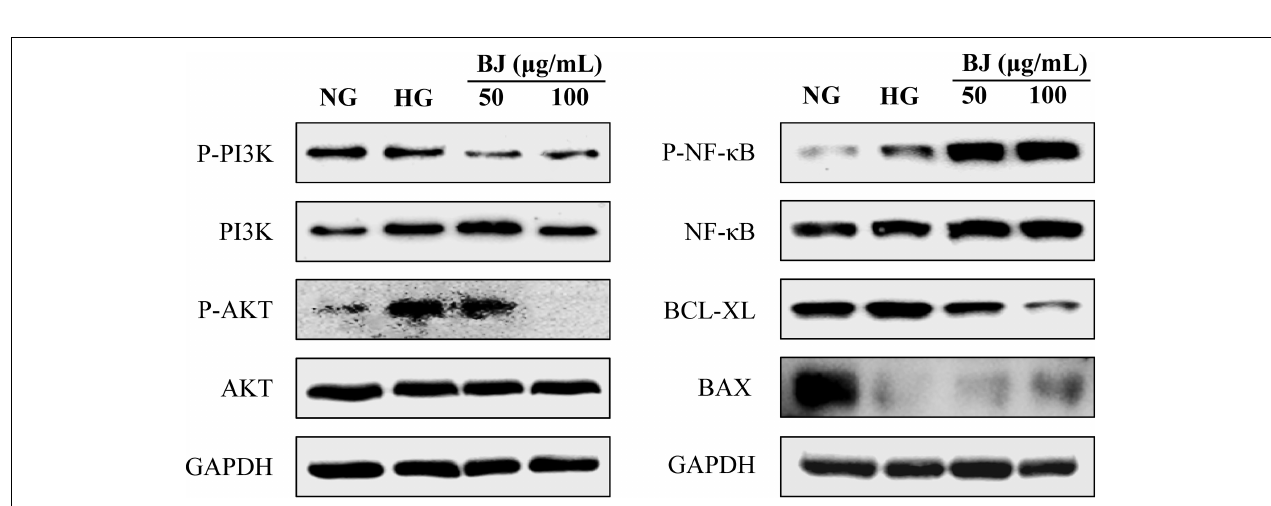
FIGURE 7 | Effect of BJ on protein expression of PI3K/AKT and NF- κ B signal pathways in HRCECs exposed to high glucose. Representative images are displayed for p-PI3K, PI3K, p-AKT, AKT, p-NF- κ B, NF- κ B, Bax, Bcl-xL, and GAPDH protein bands.